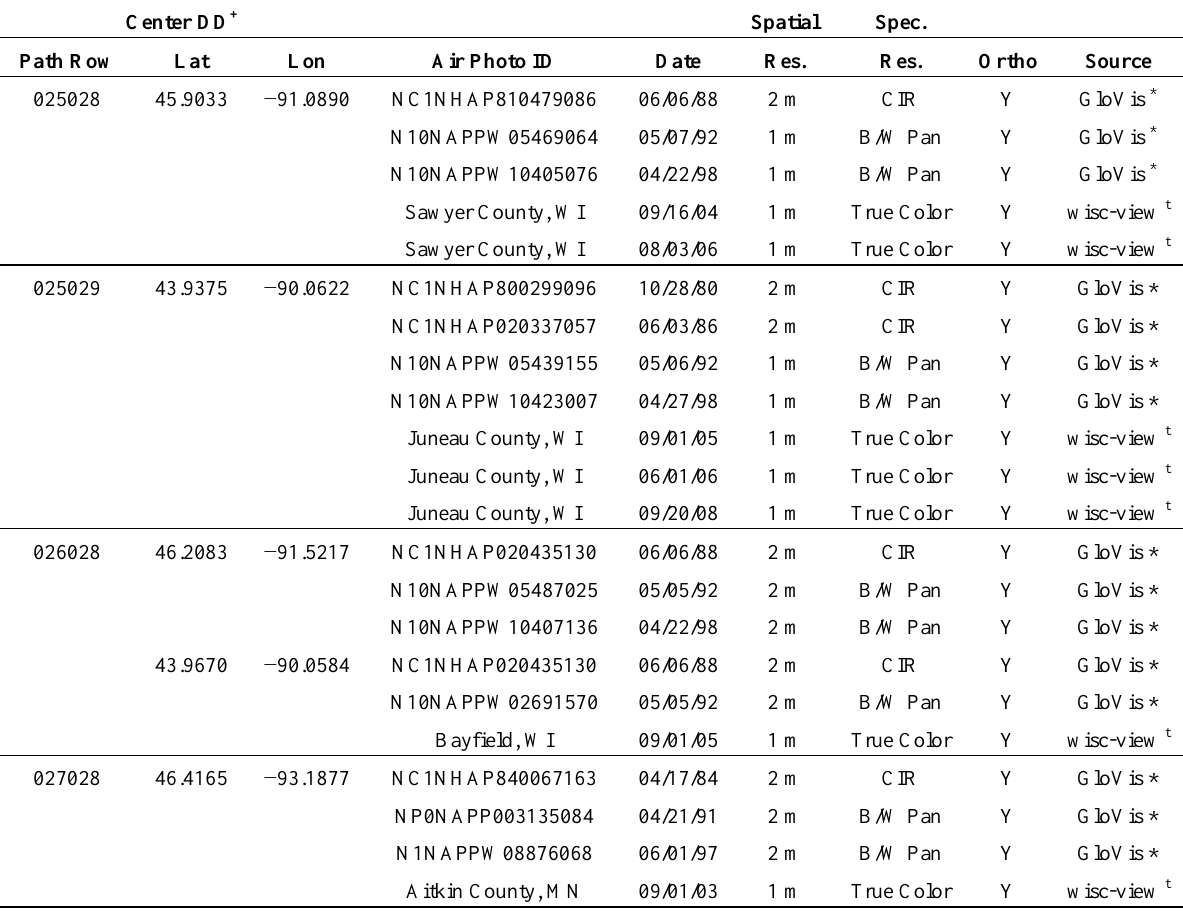
Table 1. Five locations of air photo stack classification evaluation data listed sequentially by Landsat WRS 2 path/row and the collection date of the photo stack bounds that are displayed in yellow in Figure